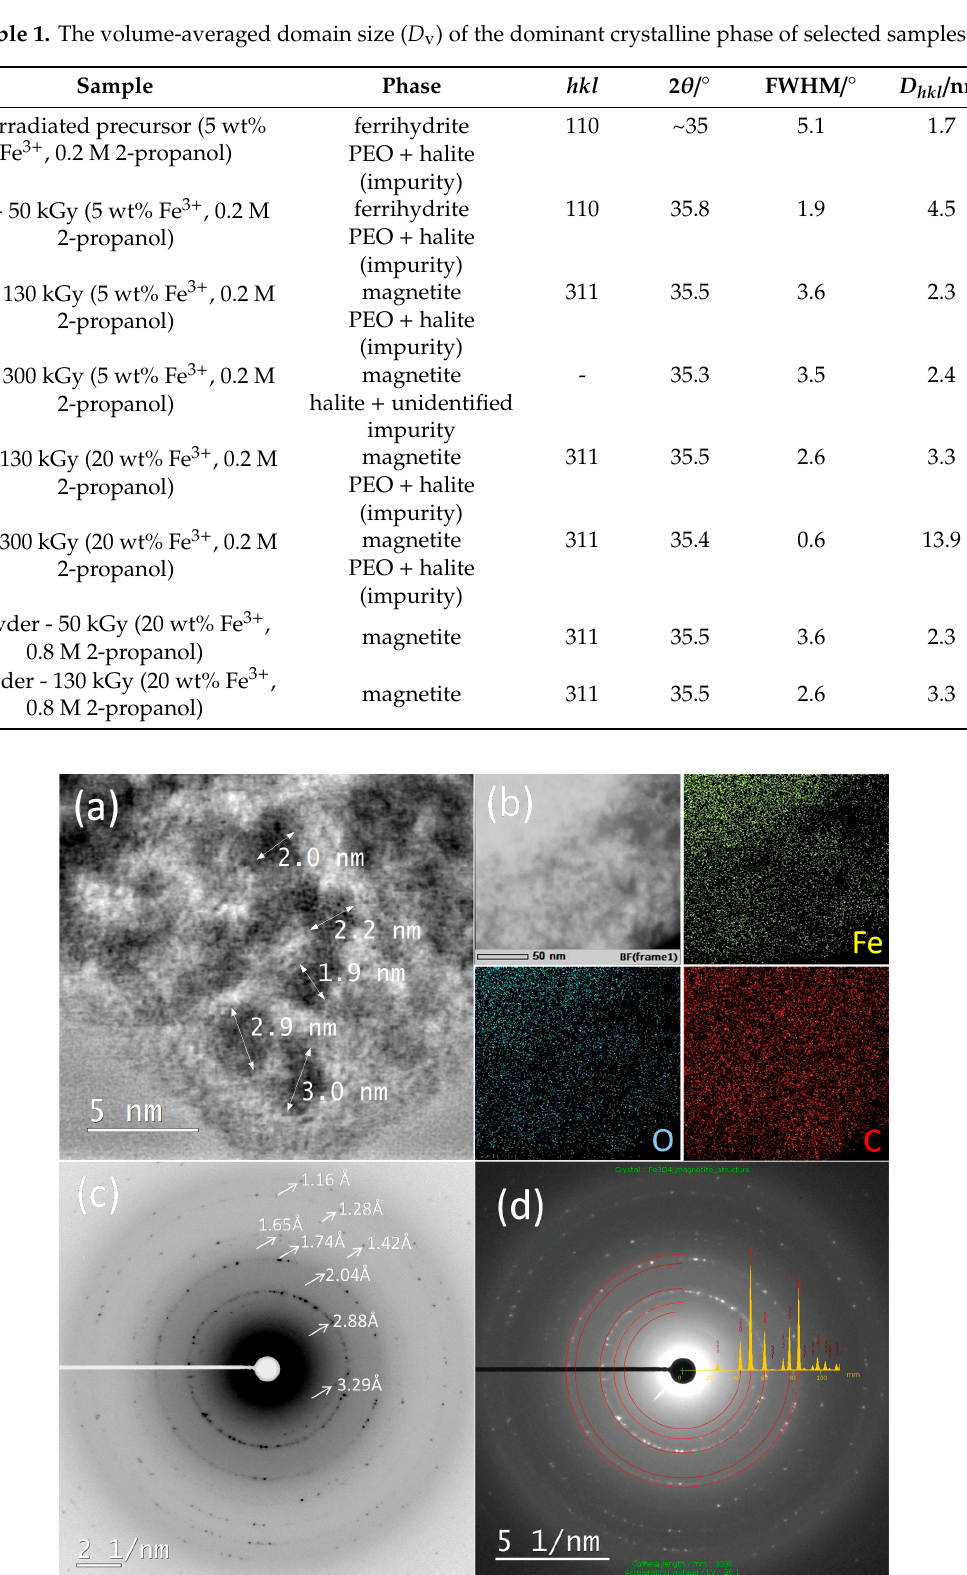
Figure 7. STEM bright-field image of the gel obtained at 130 kGy from 20 wt% Fe 3+ suspension ( a ); EDXS elemental mapping of the gel where yellow, blue, and red colors represent iron (Fe), oxygen (O), and carbon (C), respectively ( b ); SAED (selected area electron diffraction) of spherical nanoparticles (NPs) with marked interplanar distances ( c ); SAED of spherical NPs indexed as magnetite (Fe 3 O 4 ) ( d ).